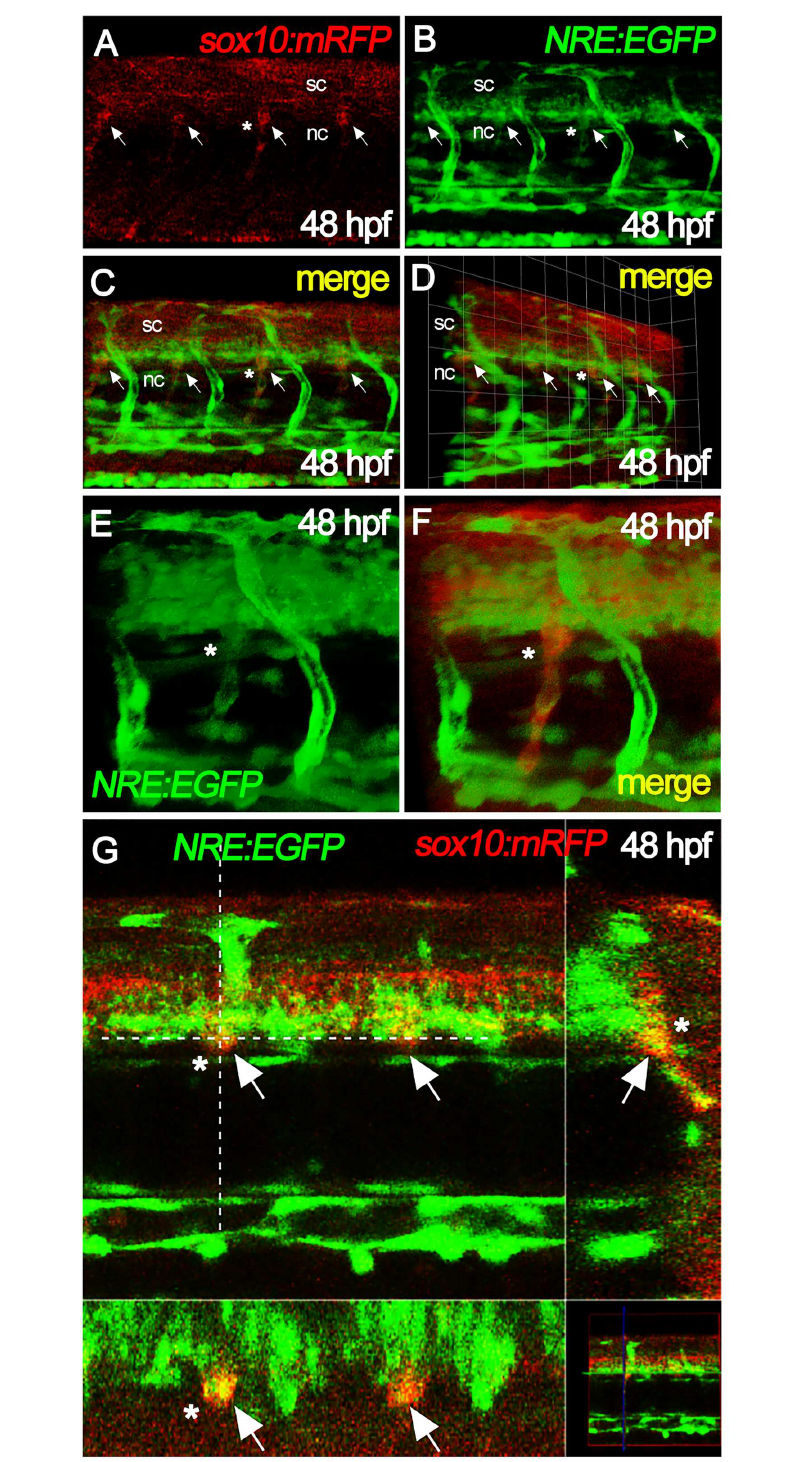
Fig 5. Notch signaling is active in nascent DRGs. Neural crest cells in the DRGs of 48 hpf embryos (arrows) were readily identifiedby expressionof mRFP reporter in sox10 : mRFP fish (A). These overlapped with eGFP expressionfrom the 12xNRE : eGFP (Notch signaling) reporter (B), as shown in superimposed image (C and D). Close-upsof individual DRGs labelledwith asterisk are shown in panelsE and F. Panel G shows DRGs (white arrows, yellow signals)as single plane acquisitions, in lateral view (top left),